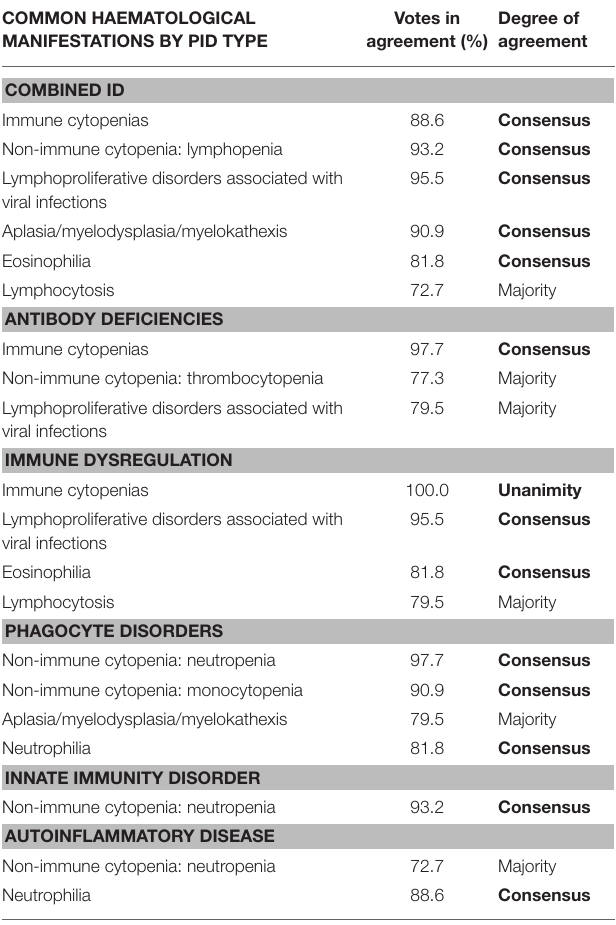
TABLE 2 | Common haematological manifestations by PID